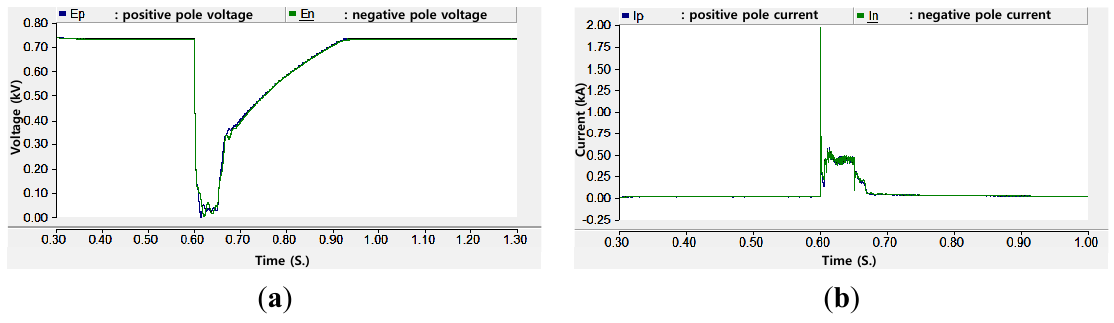
Figure 6. Resulting waveforms of U/G cable: ( a ) voltage and ( b ) current.